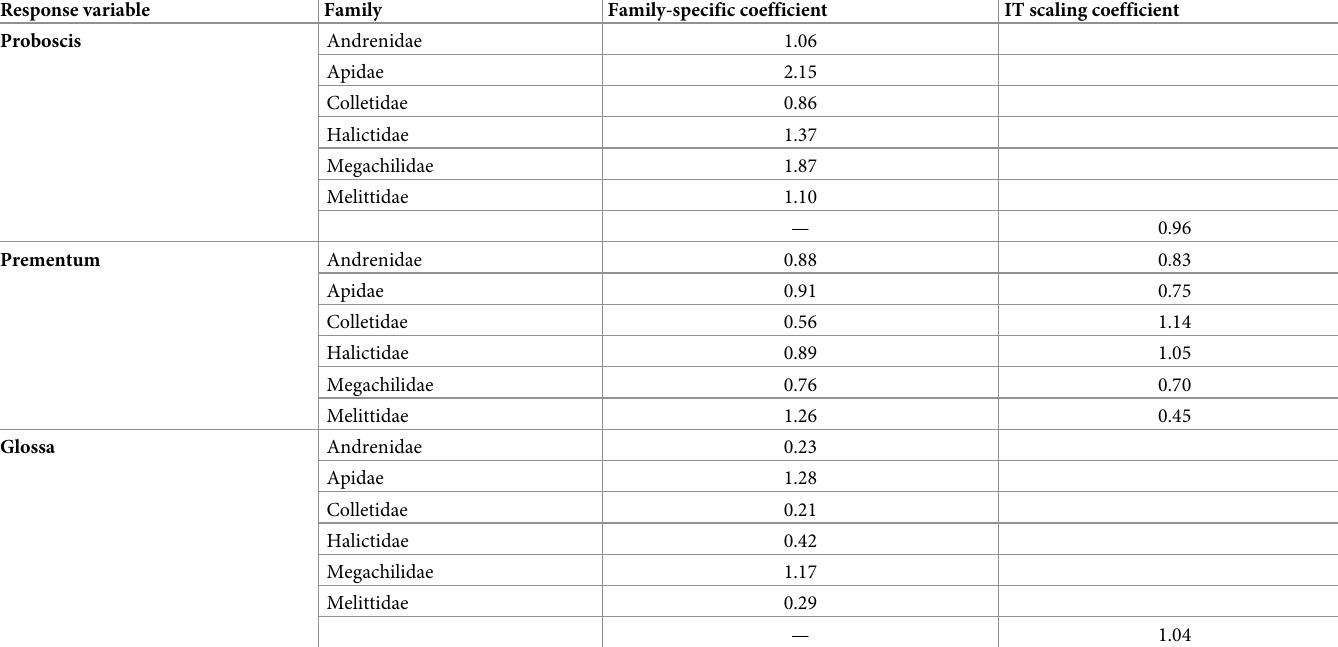
Table 2. The parameter values for the allometric power function [12] using the estimates from the best fitting (lowest AIC) OLS regression models (Table 1). Logs are in base